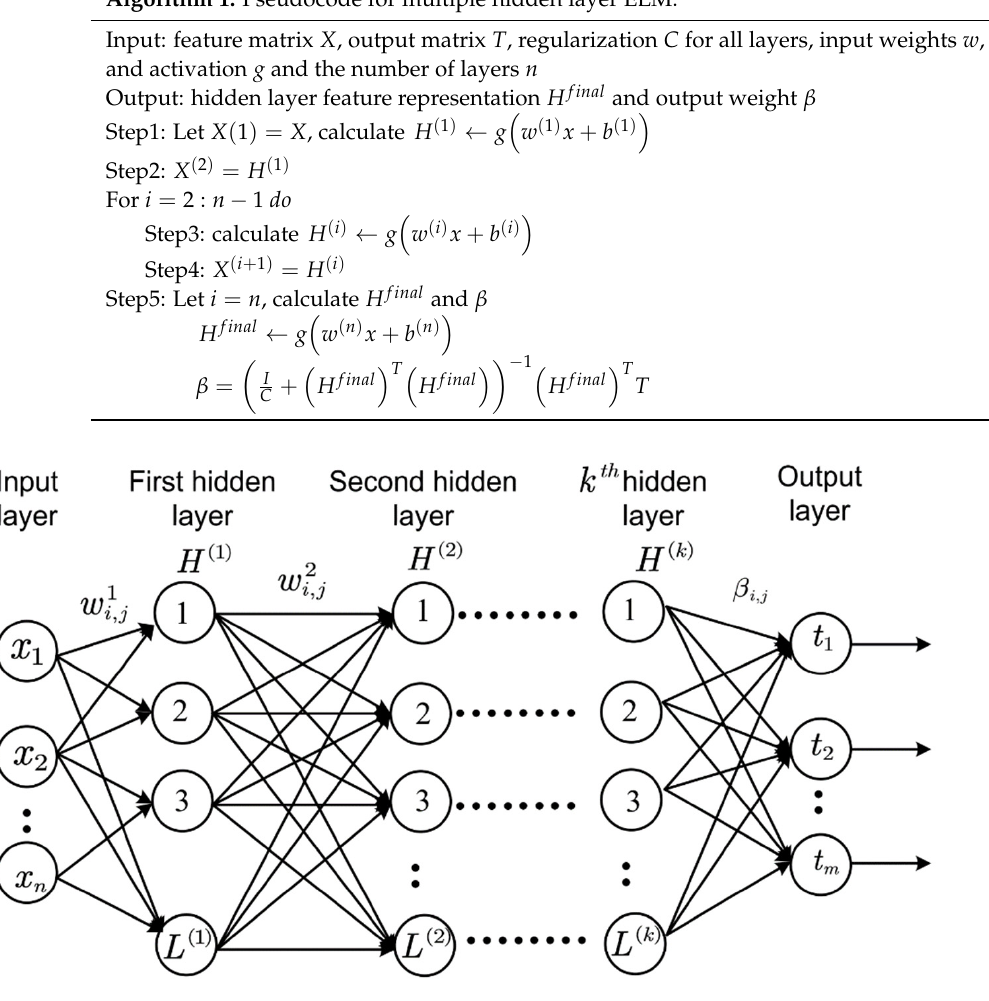
Figure 5. Architecture of Multiple hidden layer extreme learning machine. Algorithm 1. Pseudocode for multiple hidden layer ELM.